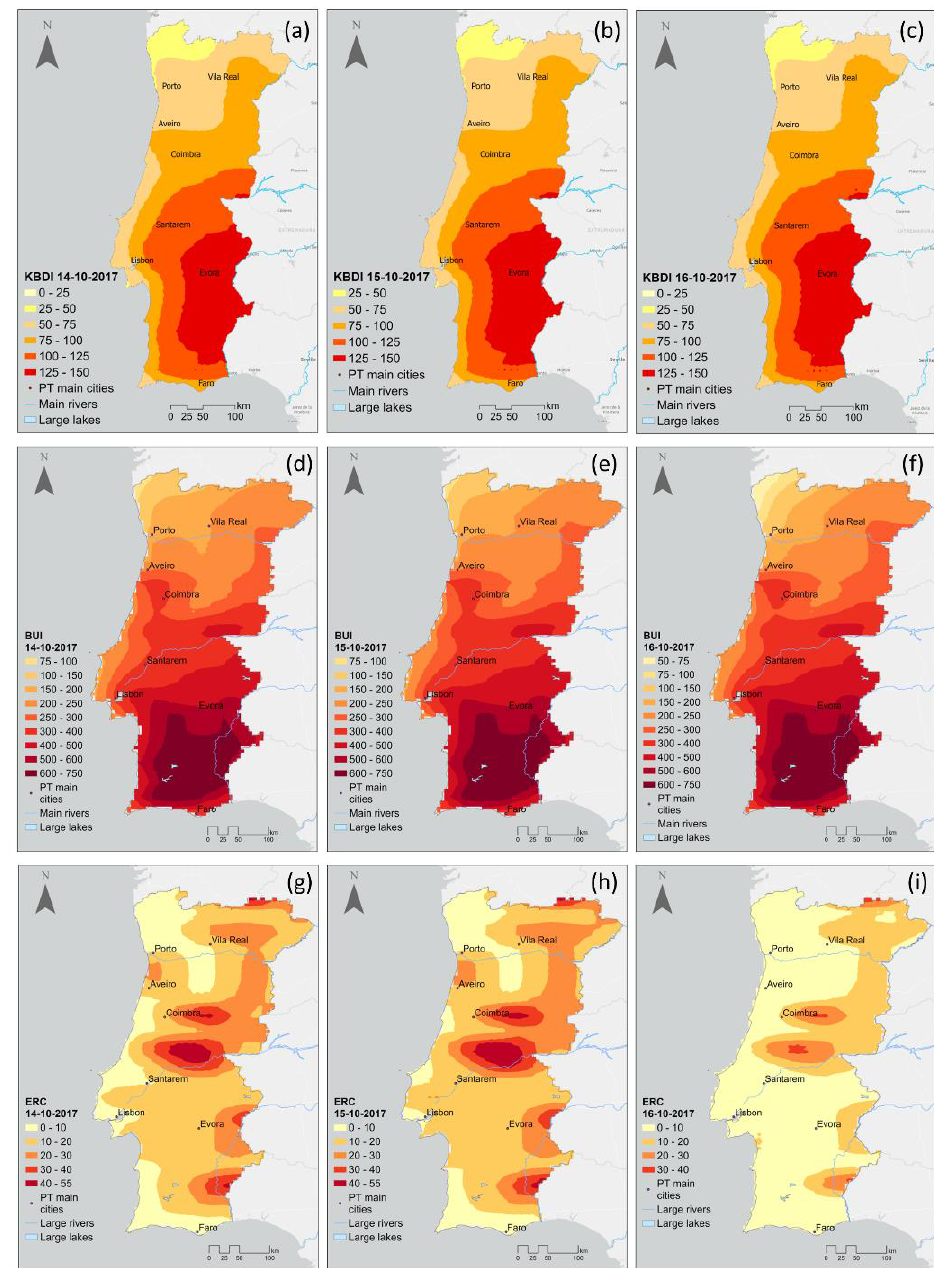
Figure 7. Daily mean values for 16 ( a , d , g ), 14 ( b , e , h ), and 15 October ( c , f , i ) 2017, for KBDI (upper row), BUI (middle row), and ERC (lower row).